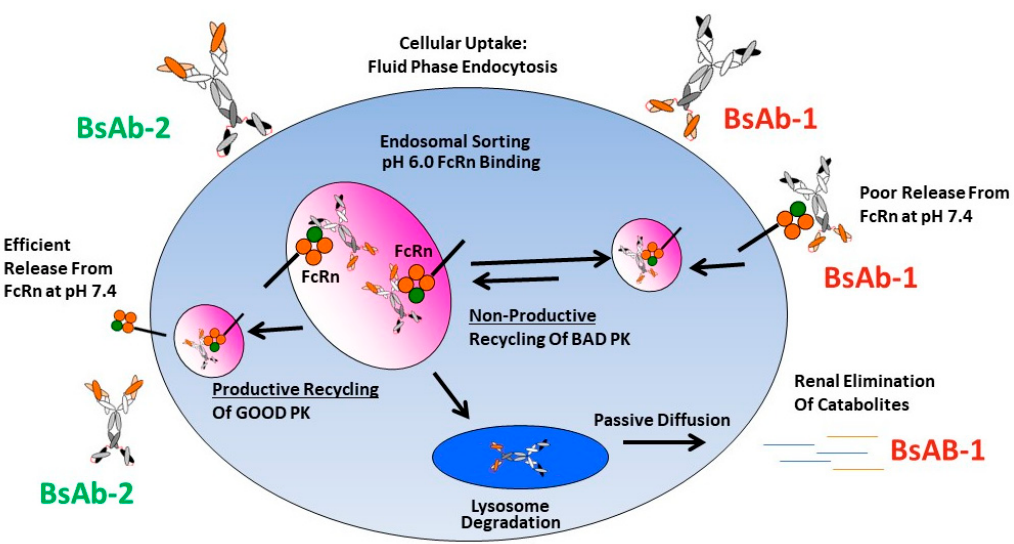
Figure 5. Mechanistic speculation of the intracellular trafficking pathways for BsAb-1 and BsAb-2 which lead to differential peripheral clearance.